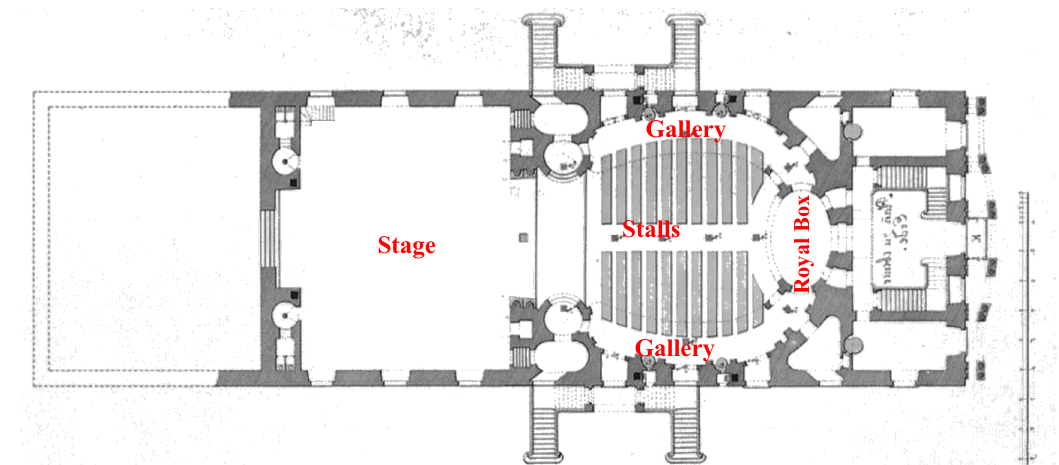
Figure 5. Plan of the theatre made by the master builder Joseph Ringer in 1789 from the National Archives (Országos Levéltár, OL T2 no. 1222, Budapest).